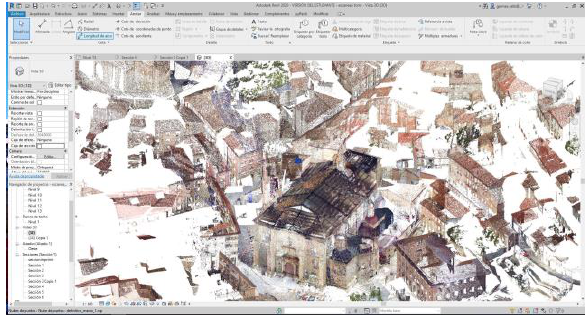
Figure 7. Point cloud in